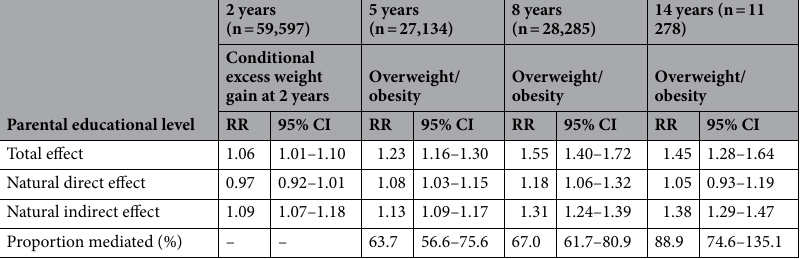
Table 2. Total, direct and indirect effects of parental education on early excess weight gain and OW/OB at 5, 8 and 14 years of the youth in the MoBa-study. Mediation model at 2 years adjusted for ethnicity and maternal civil status; Mediation models at 5, 8 and 14 years adjusted for ethnicity and maternal civil